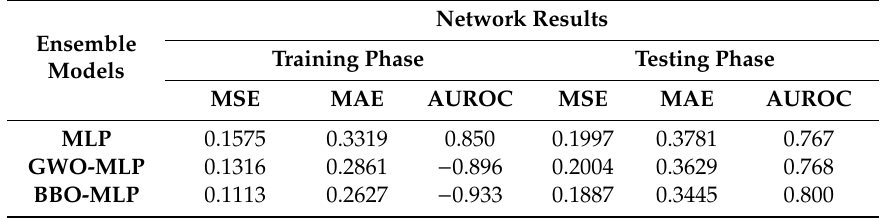
Table 3. The obtained accuracy criteria in the training and testing